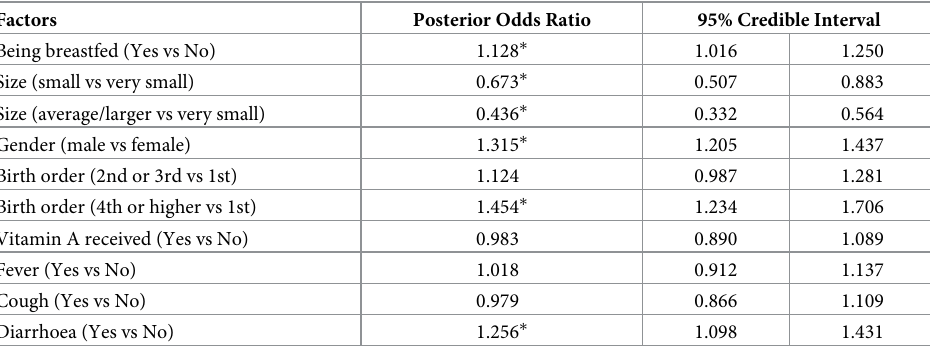
Table 5. Posterior estimates of the child-level fixed